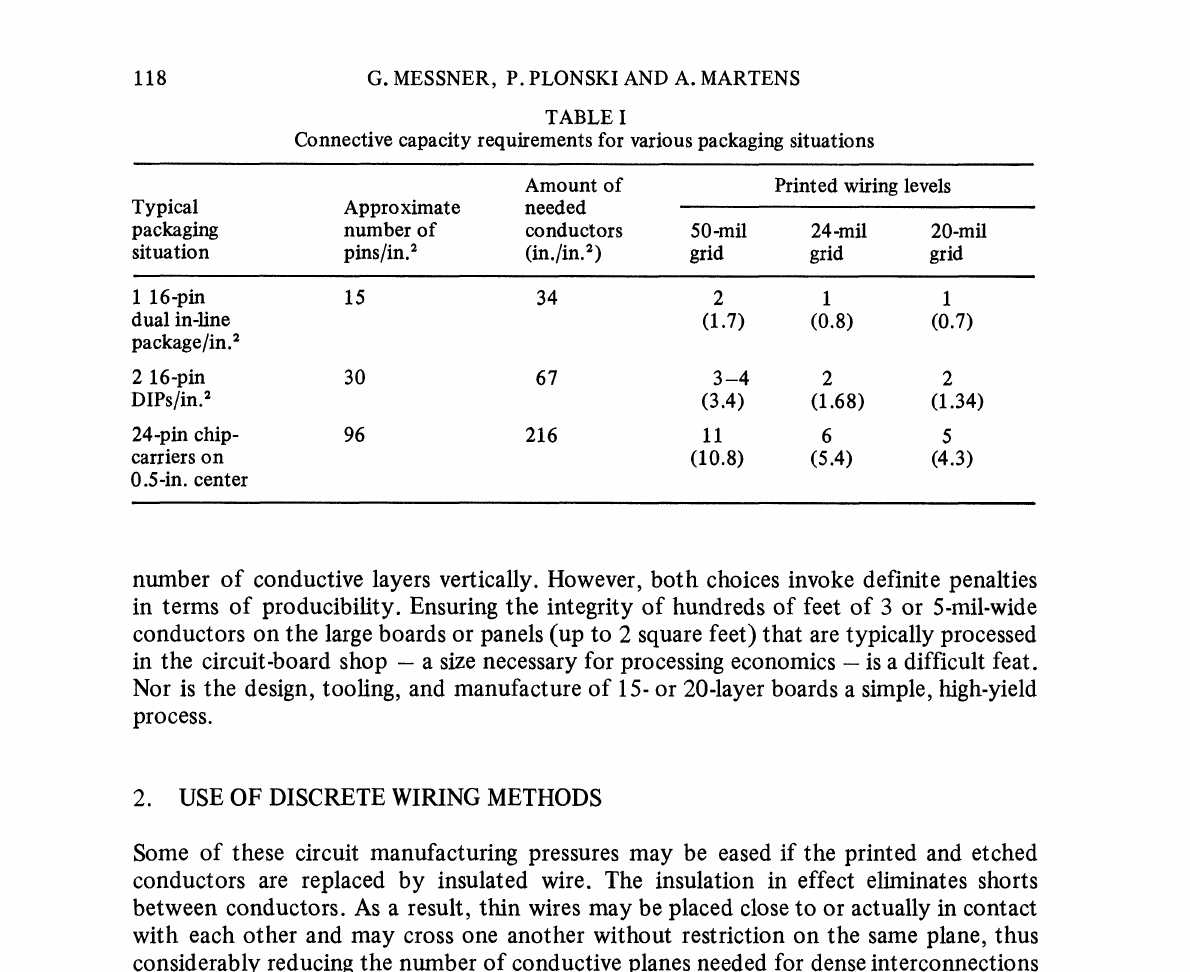
TABLE Connective capacity requirements for various packaging